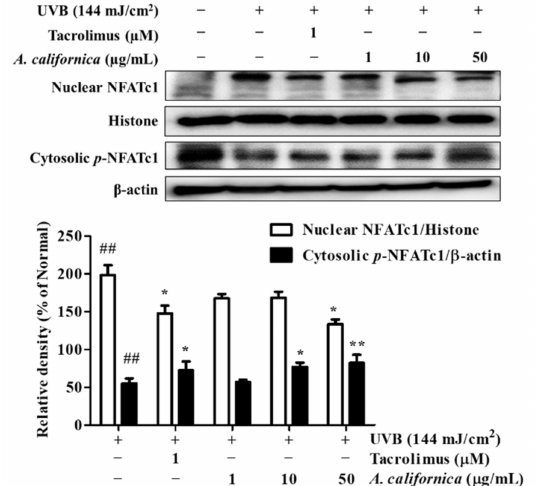
Figure 9. Effect of A. californica extract on the protein expression of nuclear NFATc1 and cytoso- lic phosphorylated NFATc1 in UVB-irradiated HDF cells. Data are presented as the mean ± SD. * indicate significant differences from the non-irradiated control and UVB-treated groups, respec- tively. ## p < 0.01 vs. the non-treated group. * and ** p < 0.05 and 0.01 vs. the UVB-treated control,